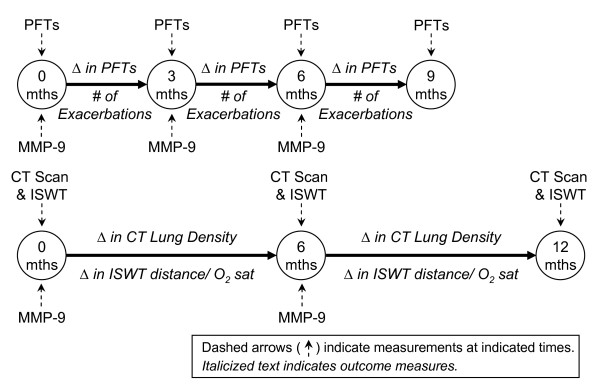
Timeline of repeated measures models for longitudinal analyses. Several repeated measures models were used to assess the longitudinal association of MMP-9 with the number (#) of subsequent COPD exacerbations or the subsequent changes (Δ) in various pulmonary status measures. The schedule of assessments for different pulmonary status measures varied in the REPAIR trial, necessitating different modeling time periods.